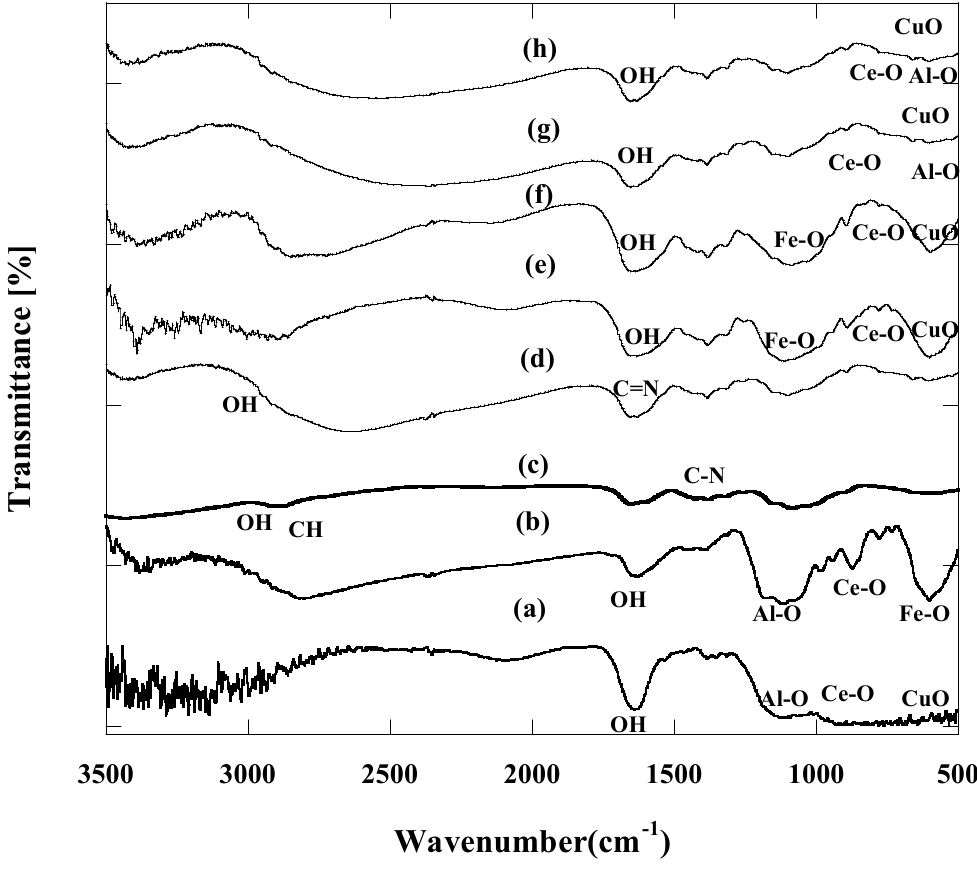
Figure 4. FT-IR before and after adsorption processes at 20 °C and pH 6 by 50 mg of: (a) CuO–CeO 2 –Al 2 O 3 (b)